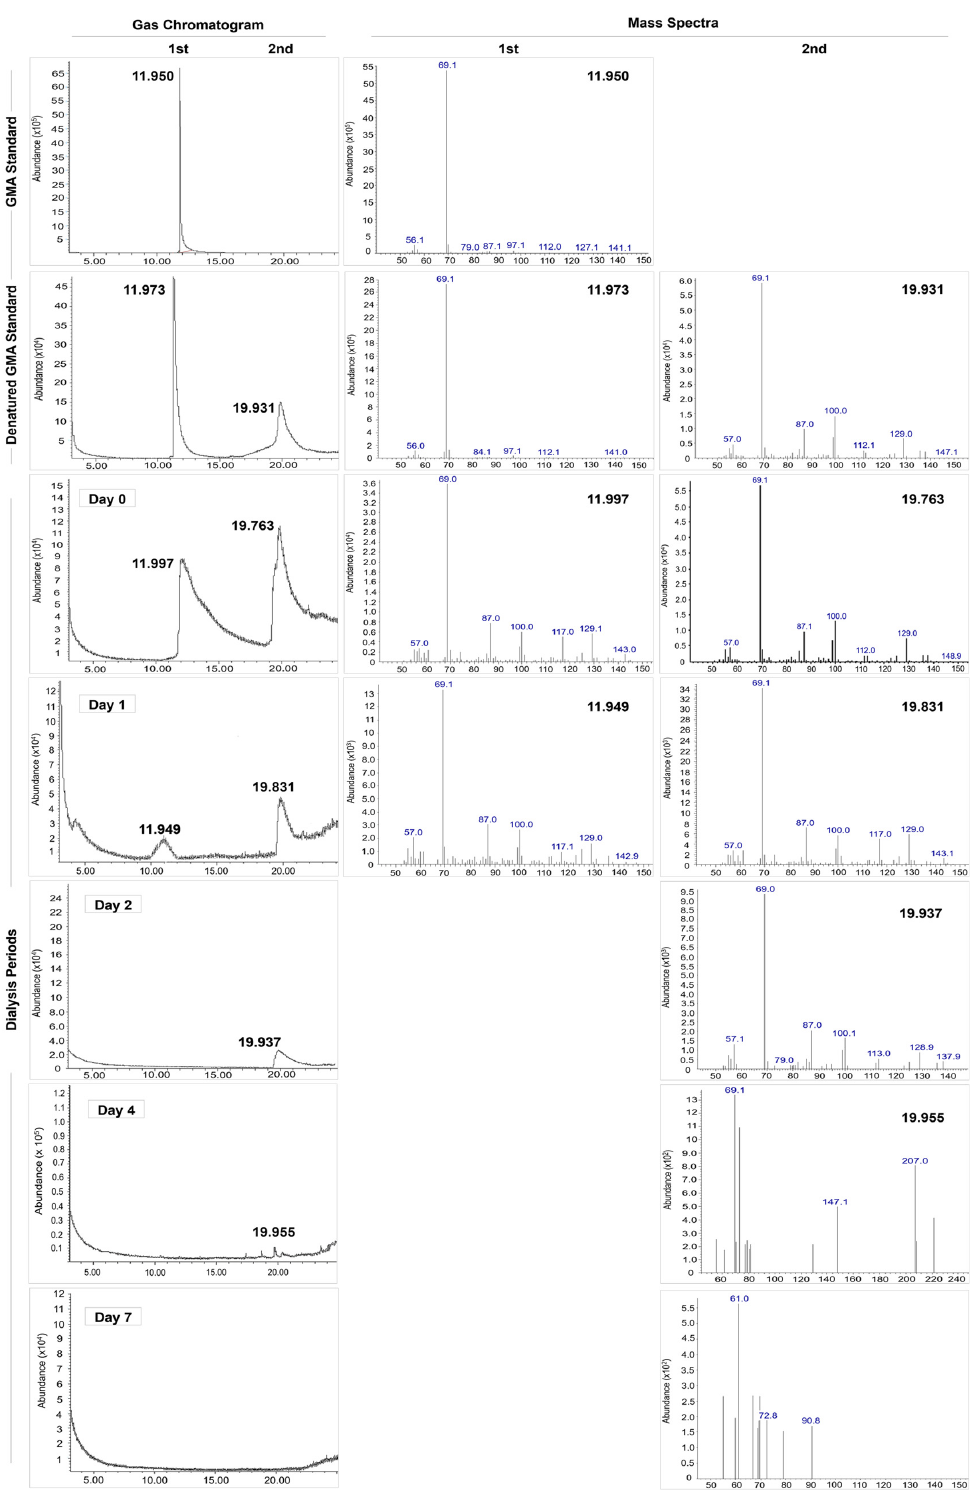
Figure 5. Gas Chromatography–Mass Spectra (GC-MS) analysis of residual GMA in the modified SF with GMA following dialysis periods. GMA and denatured GMA were used for a standard and denatured standard solution at 60 °C for 6 h with the same condition. The liquid–liquid solvent extraction with ethyl acetate was used for extraction of residual GMA. Each dialyzed sample from the GC-MS analysis showed that residual GMA reduced depending on dialysis periods in modified SF with GMA samples.